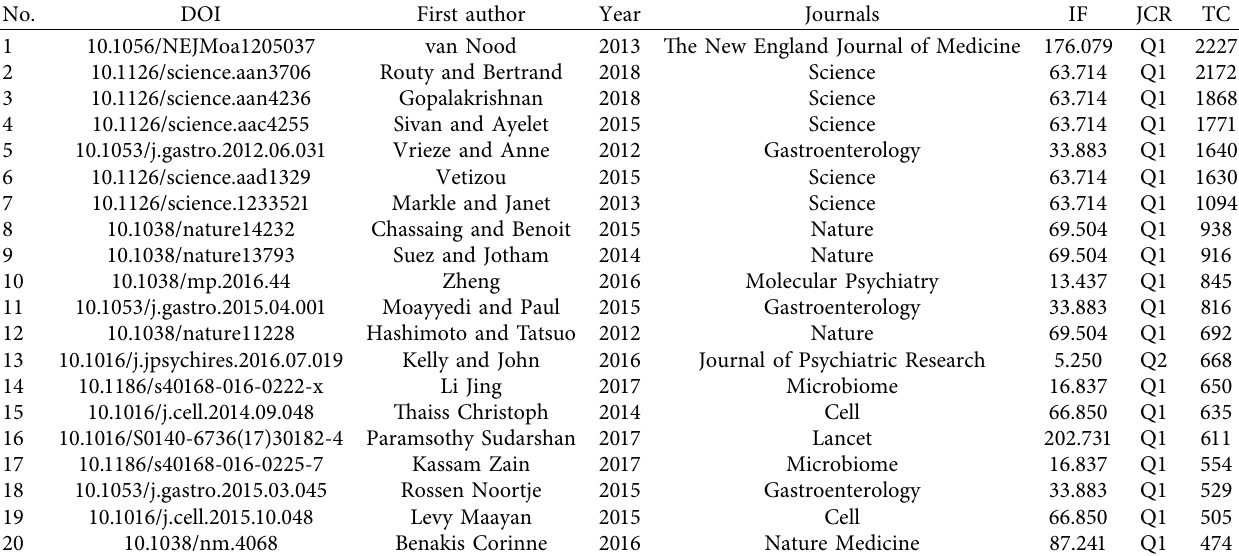
Table 6: Te top 20 high-cited FMT-related articles.